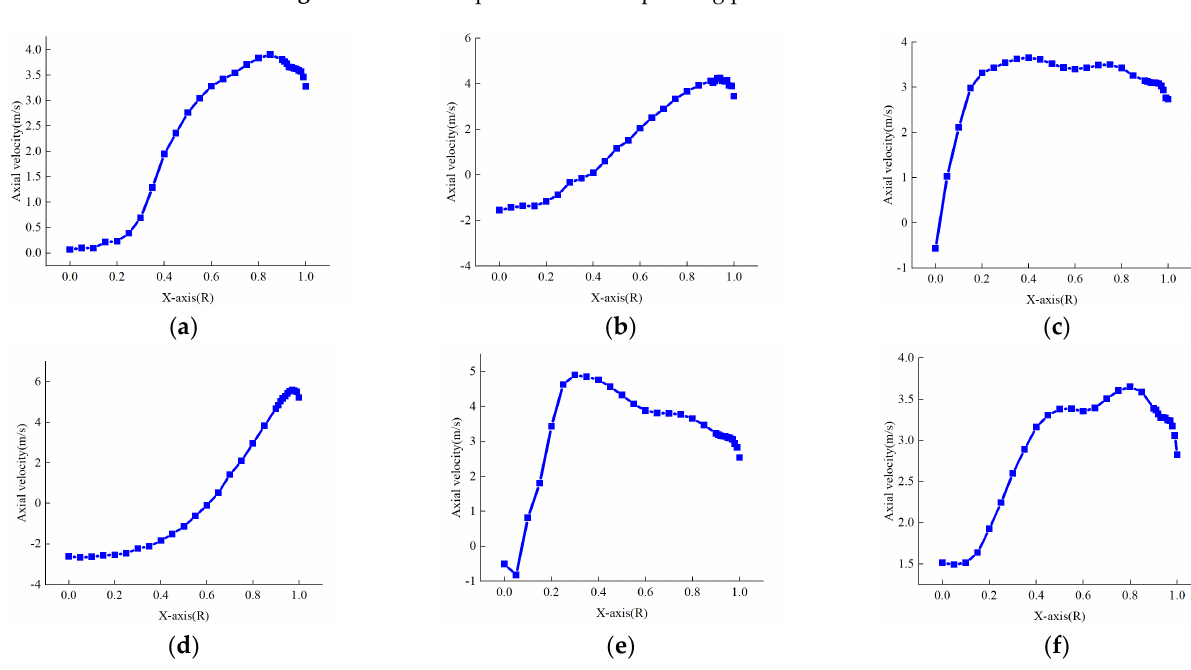
Figure 14. Vortex ropes at different operating points.